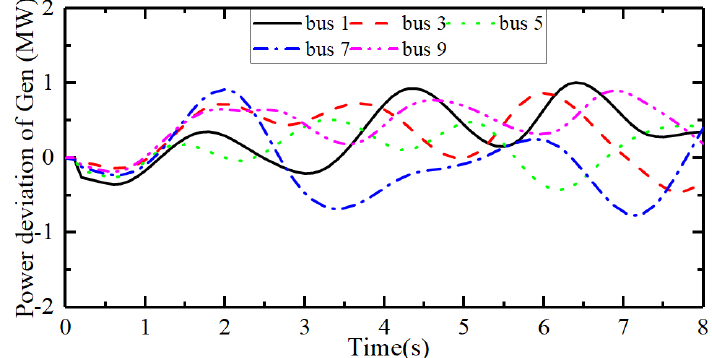
Figure 6. Generator power deviation curve.